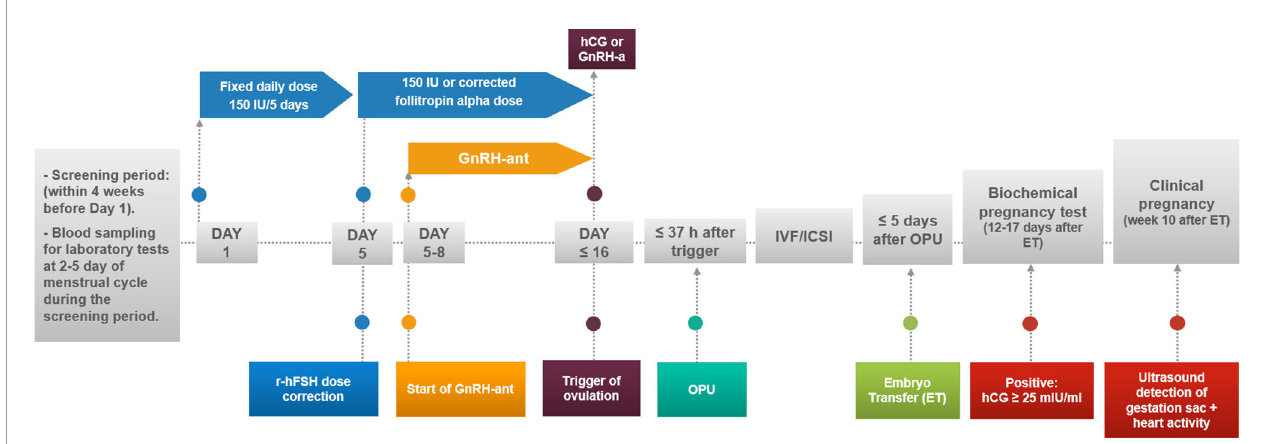
FIGURE 2 | Time-line of biospecimen collection, clinical procedures and assessment of